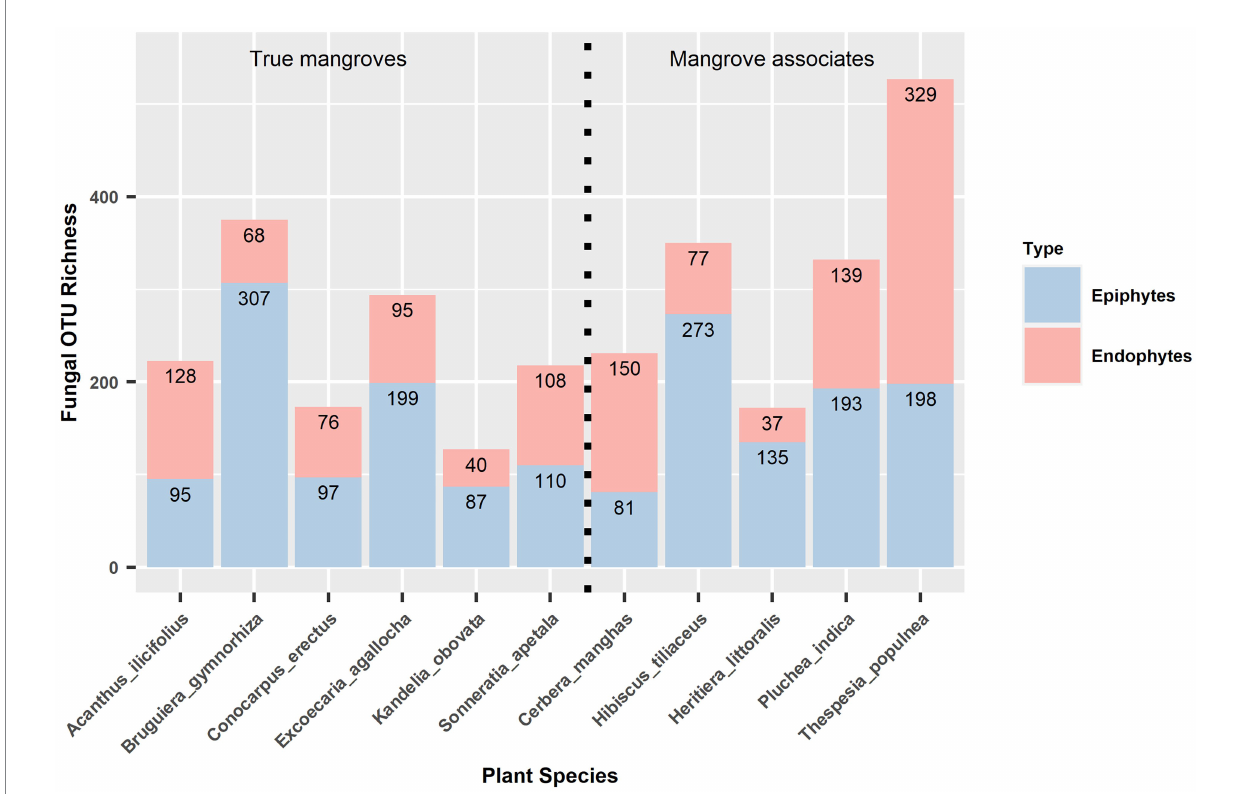
FIGURE 2 OTU richness of epiphytic and endophytic fungal communities in 11 host plant species. True mangroves and mangrove associates are showed on the left and right panels,